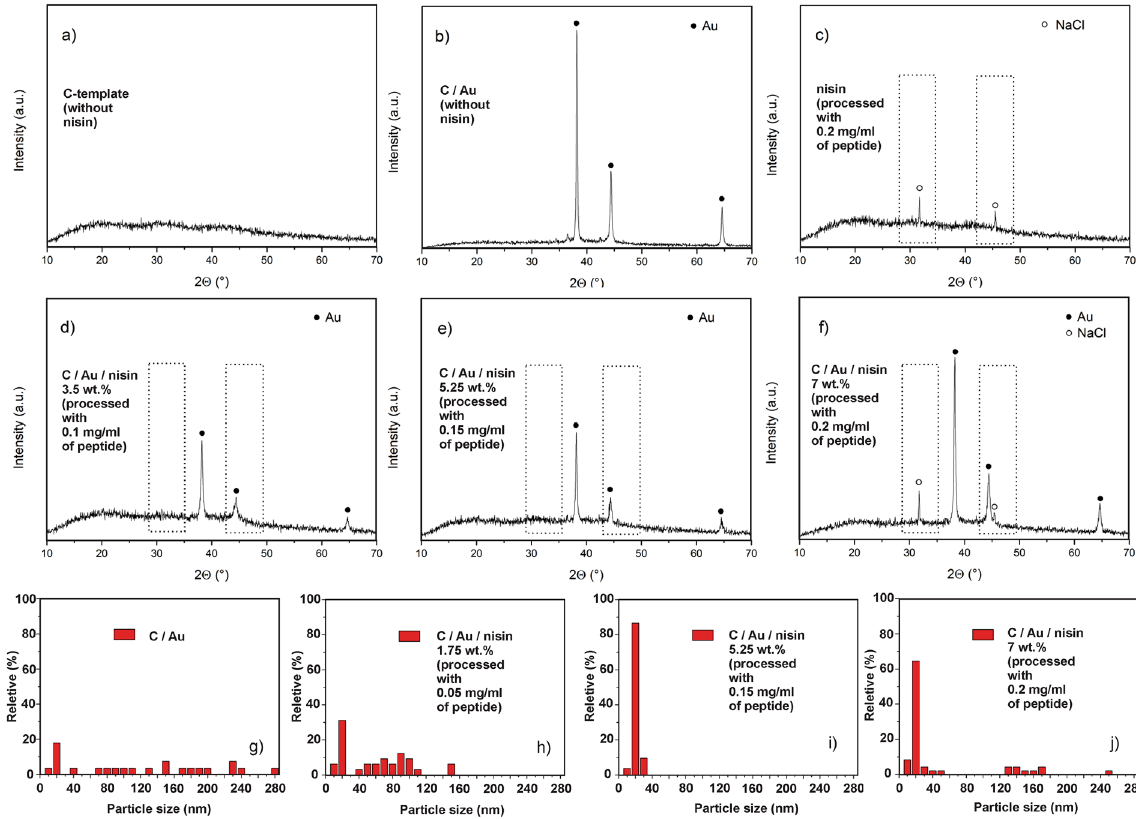
Figure 2. Composition and morphology determined by nisin. XRD patterns of C templates ( a ), C templates with Au nano-features (without nisin) ( b ), C templates with nisin (processed with 0.2 mg/ml of pure nisin) ( c ), C templates with Au nano-features functionalized with nisin (processed with 0.1, 0.15 and 0.2 mg/ml of pure nisin ( d – f ), respectively. Size distribution of Au nano-features on C templates (without nisin) ( g ), and Au nano- features on C templates processed with 0.1, 0.15 and 0.2 mg/ml of pure nisin ( g – j ),